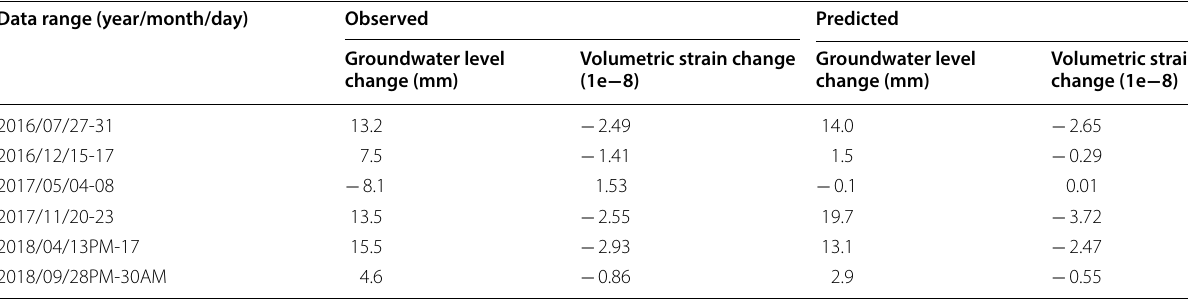
Observed volumetric strain changes were calculated from the observed groundwater level changes and crustal strain sensitivity (see Table 1). Predicted groundwater level changes were converted from the volumetric strain changes at HKSi predicted by the fault models and the observed crustal strain sensitivity